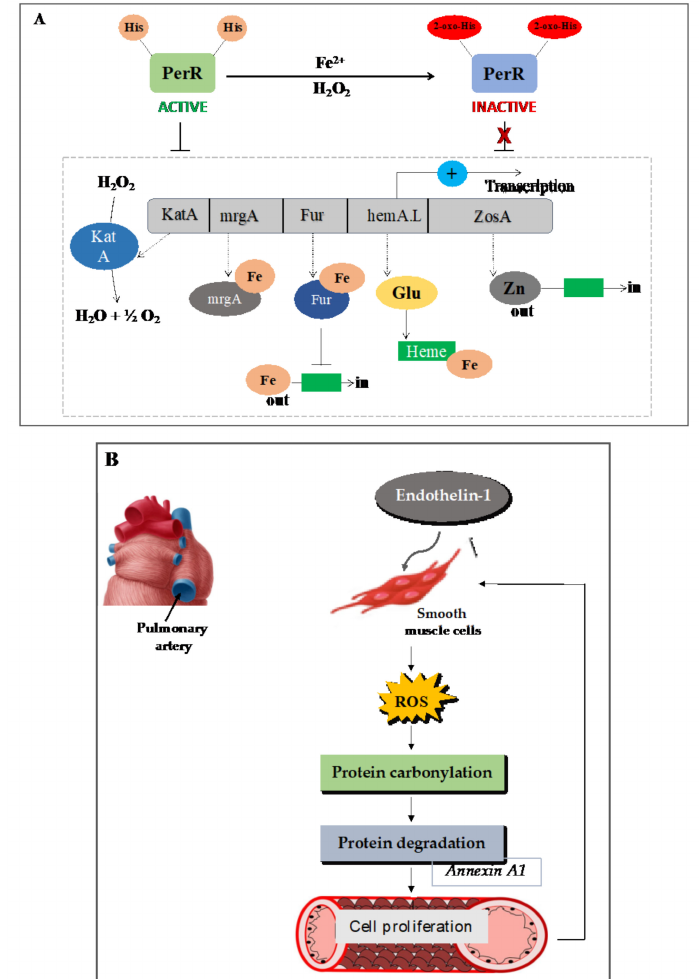
Figure 4. Examples of the implication of protein carbonylation in ROS signaling in prokaryotes and humans. ( A ) Bacilius subtilis uses metal-catalyzed oxidation of PerR for H 2 O 2 and peroxides sensing. The transcription factor PerR possesses two His residues that bind to Fe. Exposure of PerR to a low level of H 2 O 2 is sufficient to trigger one or both His residues’ oxidation, presumably via the Fenton reaction that involves the bound iron. This causes the loss of the DNA binding activity of PerR and the derepression of the PerR regulon-encoding enzymes, such as the genes katA (catalase), mrgA (nonspecific DNA-binding protein), hemAXCDBL (heme biosynthesis operon), Fur (iron uptake regulator), and ZosA (zinc-transporting ATPase), acting to detoxifying peroxides. The induced katA (catalase) removes the hydrogen peroxide to water, whereas Fur suppresses the iron intake. ( B ) Mammalian annexin A1 undergoes carbonylation as a signal transduction mechanism in response to endothelin-1 (ET-1) treatment to promote cell proliferation and apoptosis. ET-1 is known as a potent vasoconstrictor and a mitogen of pulmonary artery smooth muscle cells. ET-1 activates the proliferation of pulmonary artery smooth muscle cells through the production of ROS. ROS trigger metal-catalyzed oxidation of annexin A1 in response to ET-1 treatment. The carbonylation of annexin A1 and its subsequent degradation of promote cell proliferation and